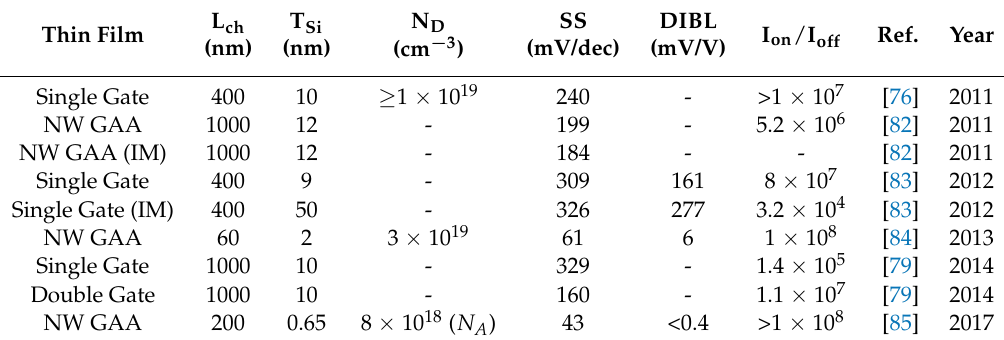
Table 4. Reported figure of merits of junctionless thin film transistors.